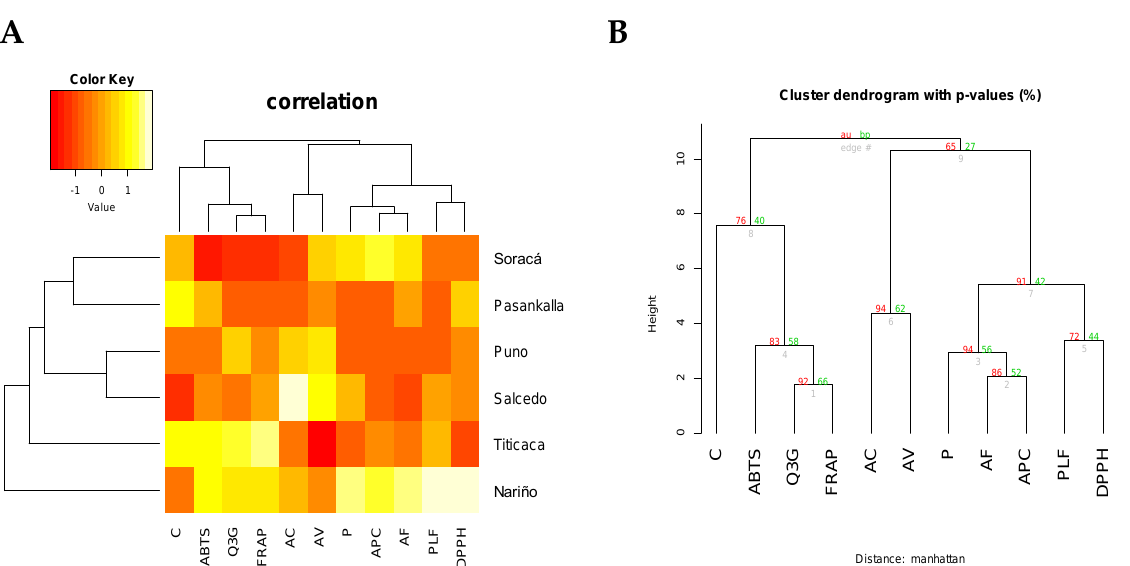
Figure 2. Sample groups according to bioactive compositions from different quinoa seeds. ( A ) Heatmap analysis according to Manhattan distance. ( B ) Boostrap grouping. AU: ap-proximately unbiased. BP: bootstrap probability. C: caffeine, Q3G: quercetin-3-glucoside. AC: caffeic acid; AV: vanillic acid. P: pinocembrin; AF: ferulic acid. APC: p -coumaric acid and, PLF: total polyphenols.